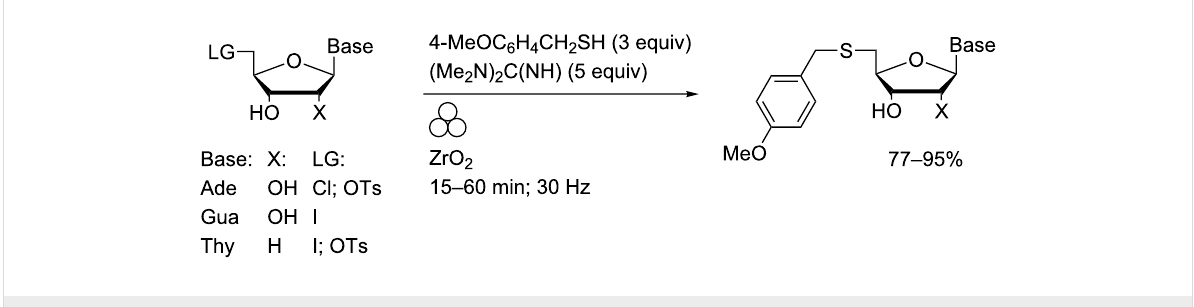
Scheme 7: Thiolate displacement reactions of nucleoside derivatives in a MBM.